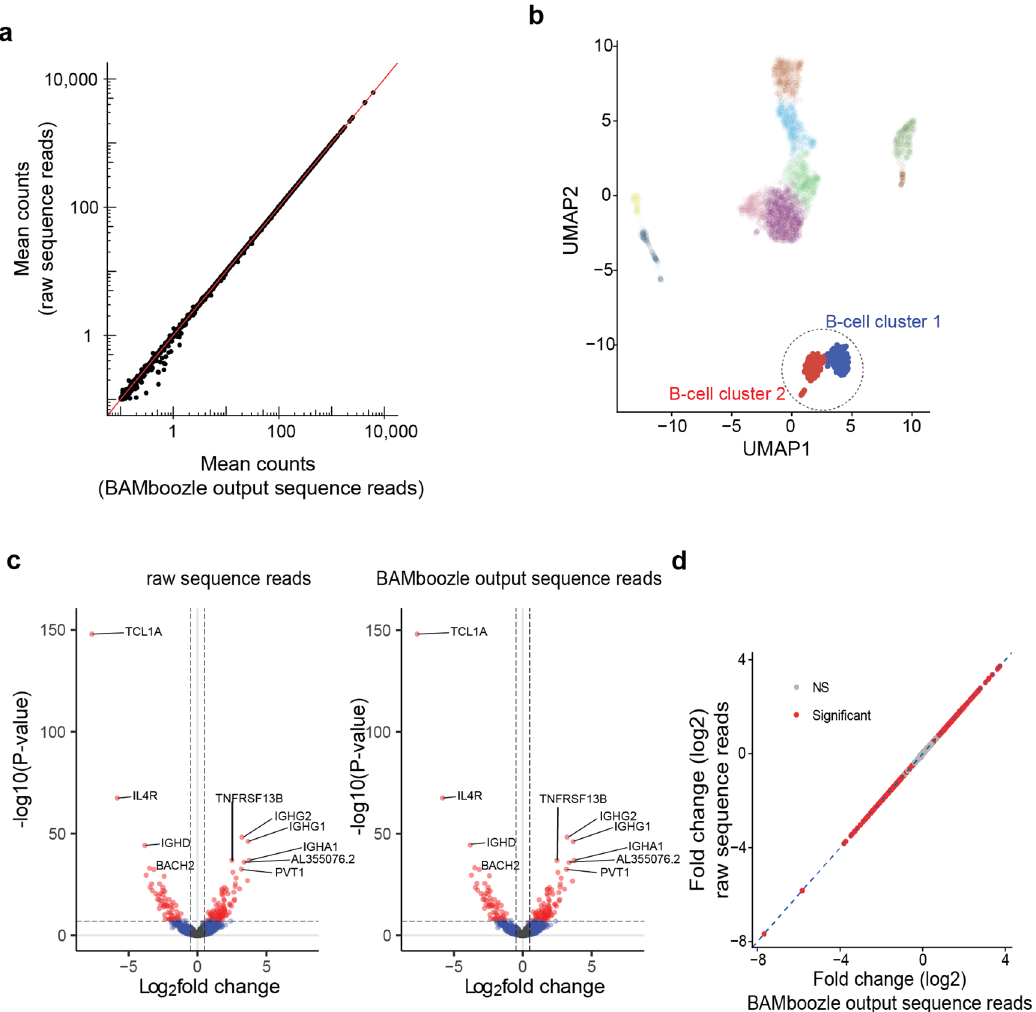
Fig. 3 Accurate cellular transcriptomes in single-cell RNA-seq data after removal of genetic variants. a Scatter plot showing accurate gene expression patterns in raw ( y -axis) and BAMboozle -processed ( x -axis) single-cell RNA-sequencing data. Data from 366 cells and 19,833 detected genes. b UMAP generated from processed sequence data maintains cell-type and state granularity, highlighting the two B cell clusters. c Volcano plots showing adjusted p values and log-fold changes (computed with limma-trend) in a comparison of B cell clusters 1 and 2, based on raw (left) and processed (right) sequence data, respectively. Genes are colored according to signi fi cance. d Scatter plots showing correlation in gene-level fold-changes estimated with limma-trend between B cell cluster 1 and